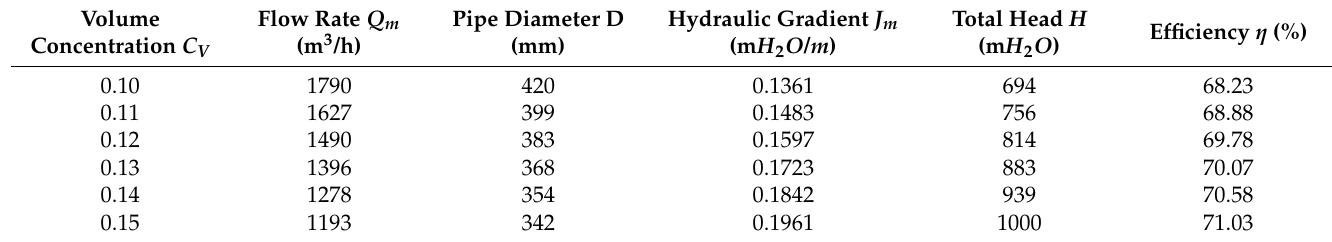
Table 1. Relation between process parameters and volume concentration of 5200 m lifting